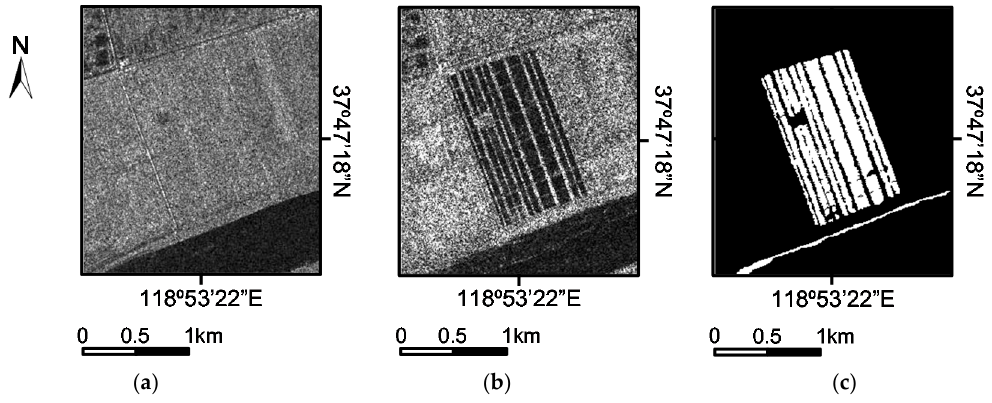
Figure 6. Yellow River dataset. ( a ) Image acquired in 2008. ( b ) Image acquired in 2009. ( c ) Ground truth change map created by on-the-spot investigation and expert knowledge.